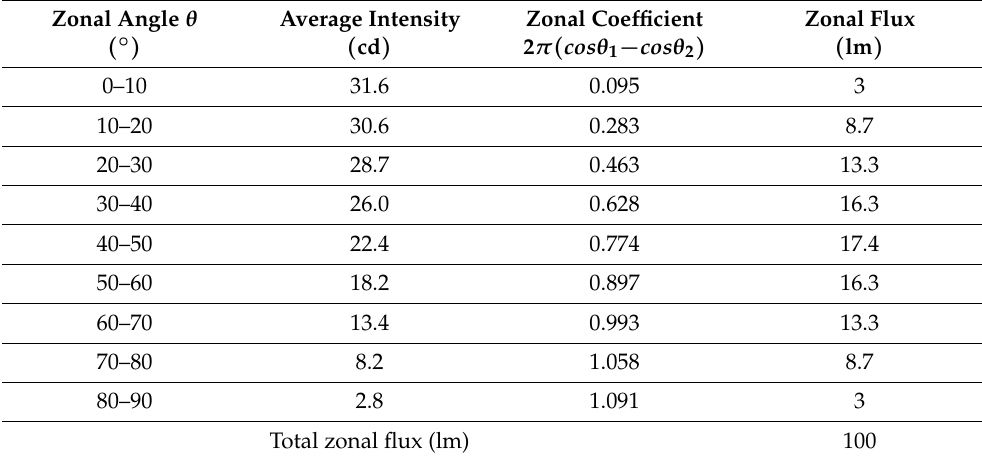
Table 2. Zonal flux analysis for Lambertian LED (100 lm).